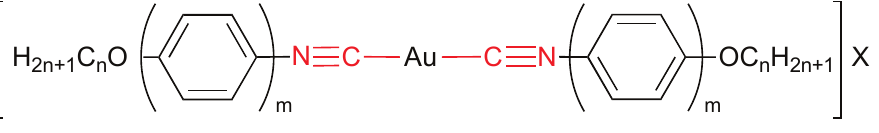
, BF ; m = 1, 2; n = 4, 8, 6 4